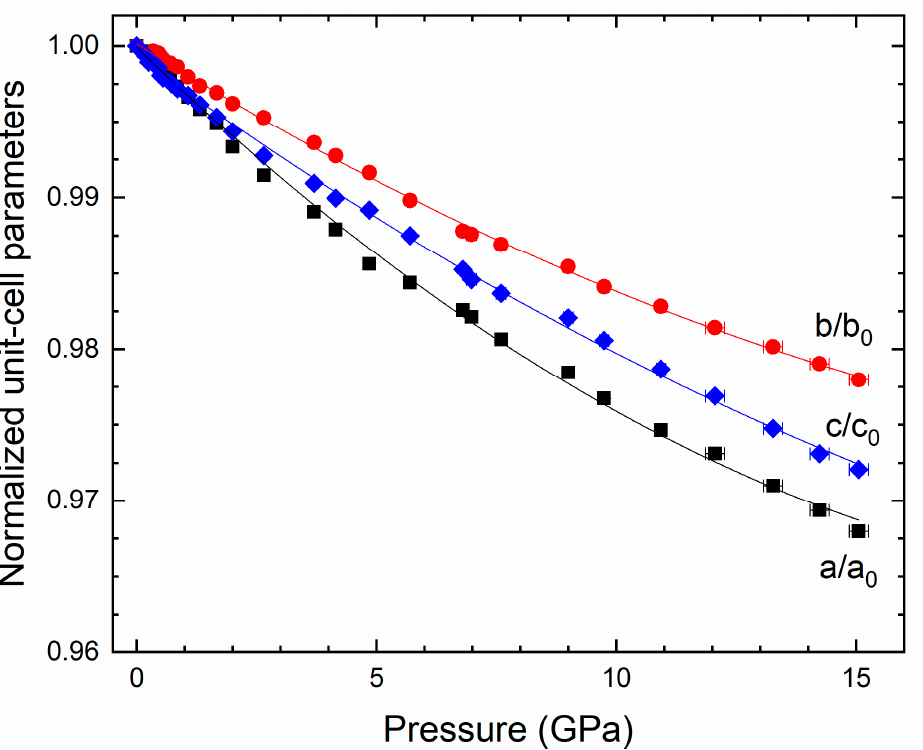
Figure 6. Normalized unit-cell parameters of Ni 3 V 2 O 8 as a function of pressure. Symbols are the results from Le Bail refinements. The lines describe unidirectional equations of state (EOSs) described in the text. Where not shown error bars are comparable to symbols’ size.